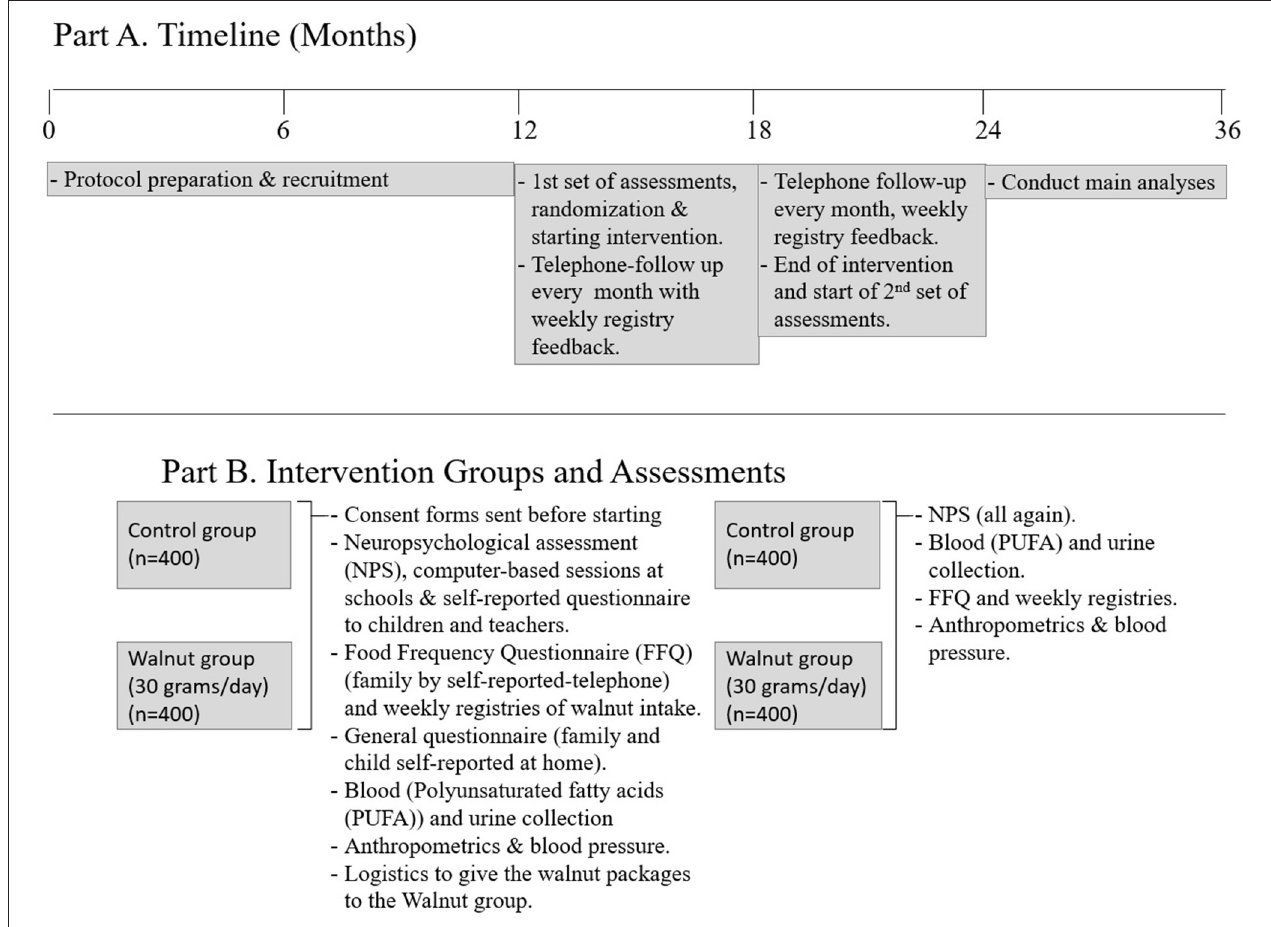
FIGURE 1 | Project design and